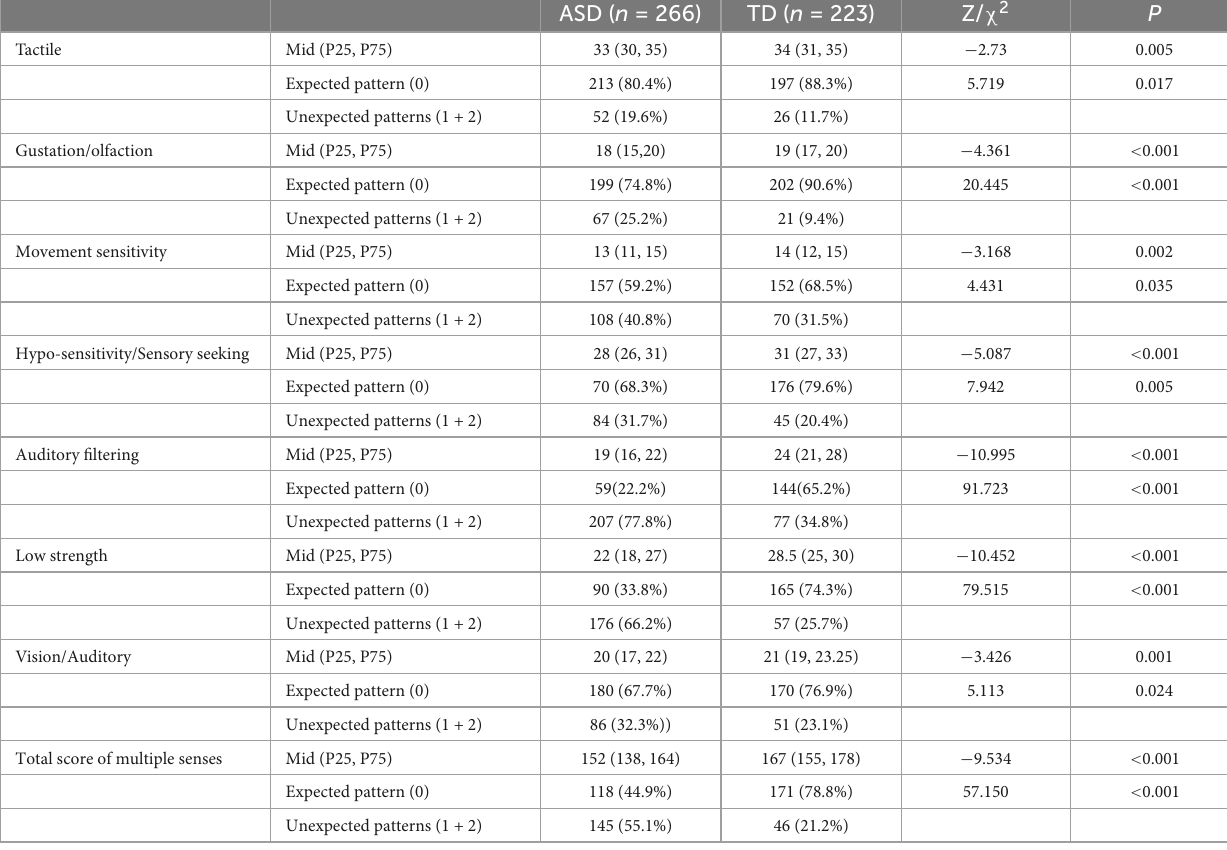
TABLE 1 Comparison of SSP score characteristics between ASD group and healthy control [Mid (P25, P75)/ n (%)].